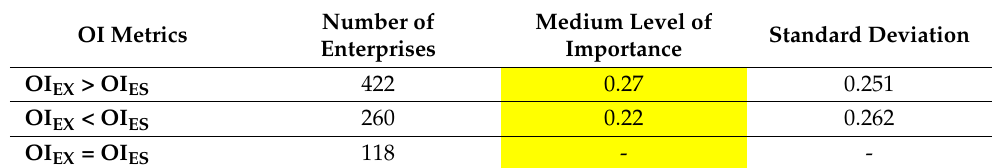
Table 9. Value of OI metrics for verification H1b ( p = 0.0066 <